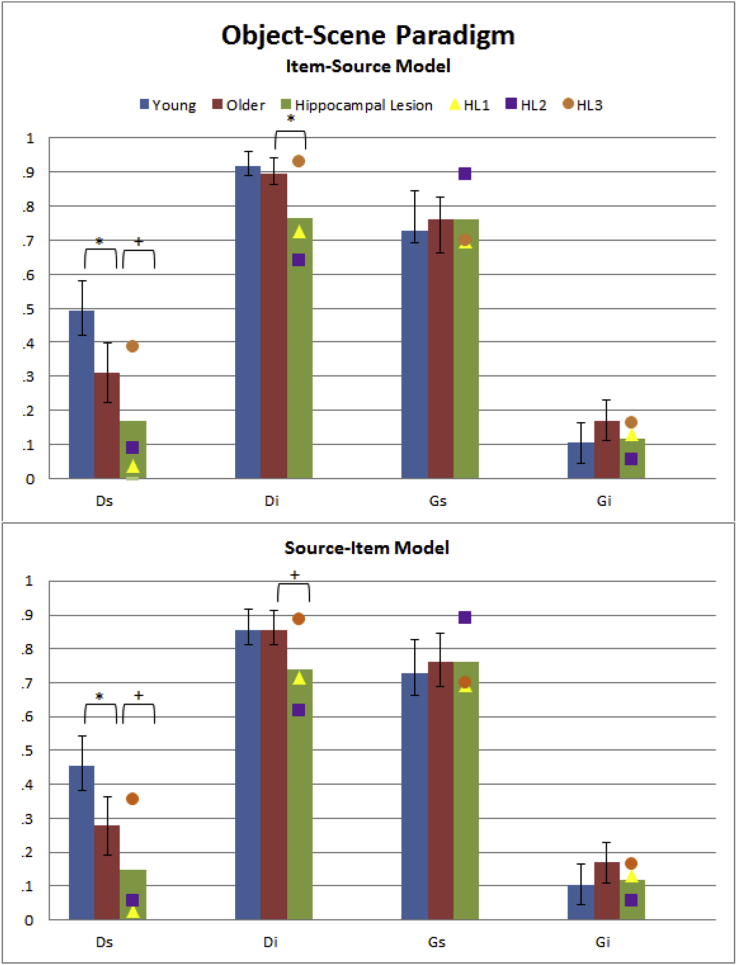
Individual parameter estimates averaged per group for MPT Item-Source and Source-Item models on the Object-Scene paradigm for Young, Older, and Hippocampal Lesion (HL) groups. Note that the Gs and Gi are constrained to be identical across the two models (see Supplementary Material). See Fig. 5 legend for more details.